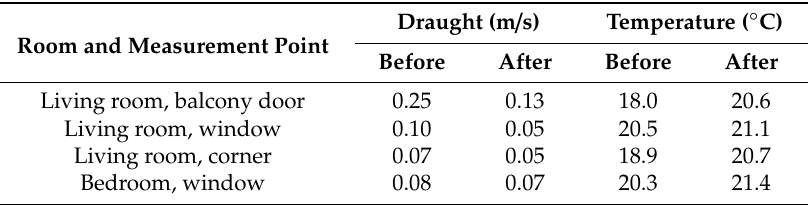
Table 4. Momentary measurements of the draughts in the rooms before and after the renovation (averages of all apartments).